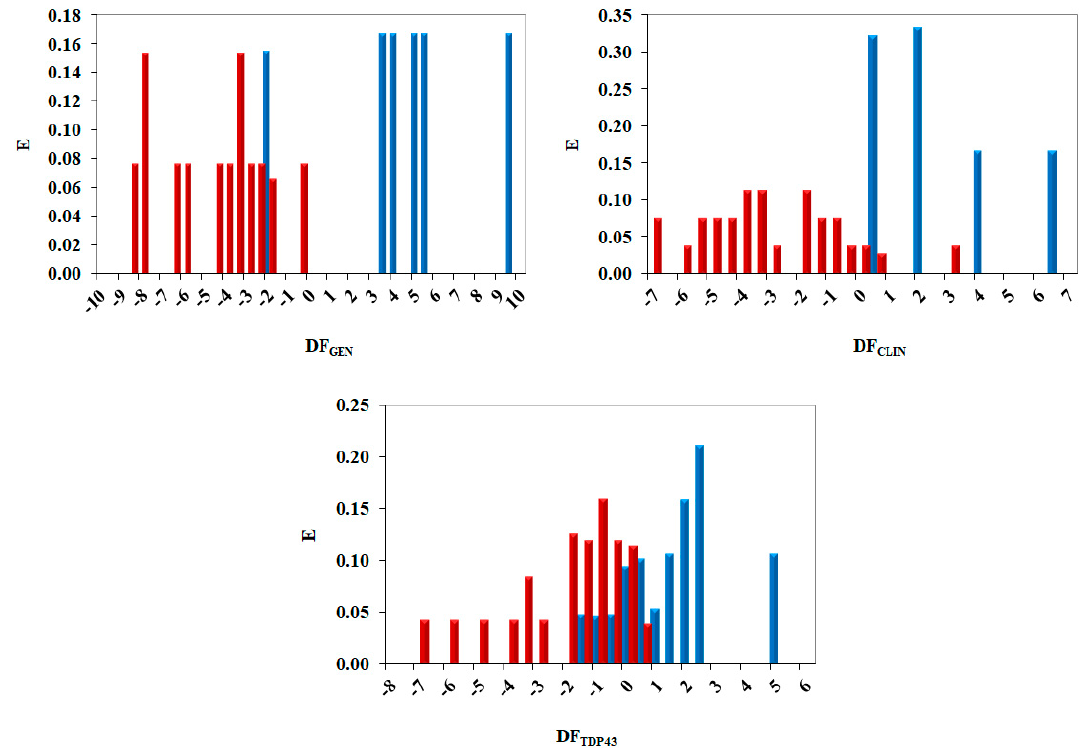
Figure 5. The pharmacological distribution diagram (PDD) for DF GEN, DF CLIN and DF TDP43 : active compounds are represented by blue bars, whereas inactive/decoys compounds are represented by red bars.